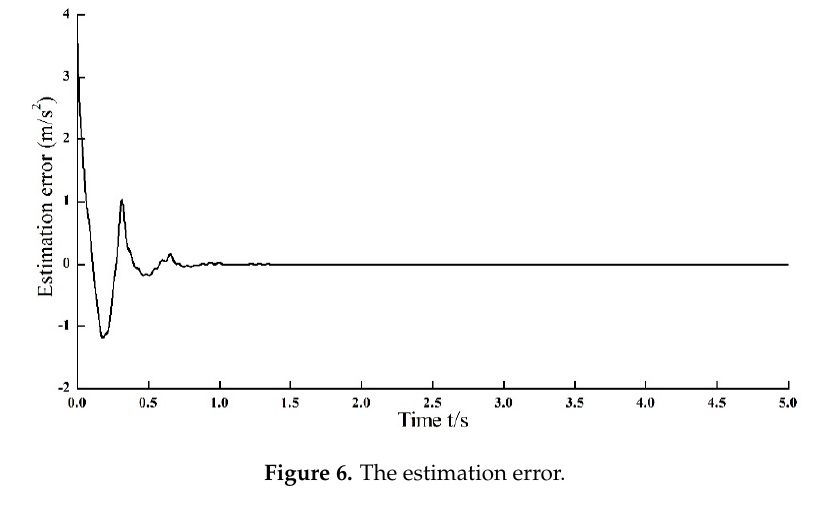
Figure 6. The estimation error.